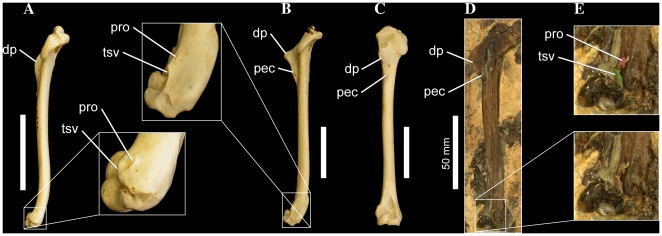
Right humeri of several waterbird taxa.
Ciconia abdimii FMNH 368771 (A), Fregata magnificens FMNH 339418 (B, C), and Limnofregata azygosternon UWGM 6919 (D, E), in medial (A, B; with distal portion enlarged), anterior (C), and anteromedial (D, E; with distal portion enlarged, and color-coded in E). Scale bars equal 50 mm. Abbreviations: dp, deltopectoral crest; pec, tubercle for attachment of m. pectoralis superficialis, pars deep; pro, scar for attachment of m. pronator superficialis; tsv, tuberculum supracondylare ventrale.